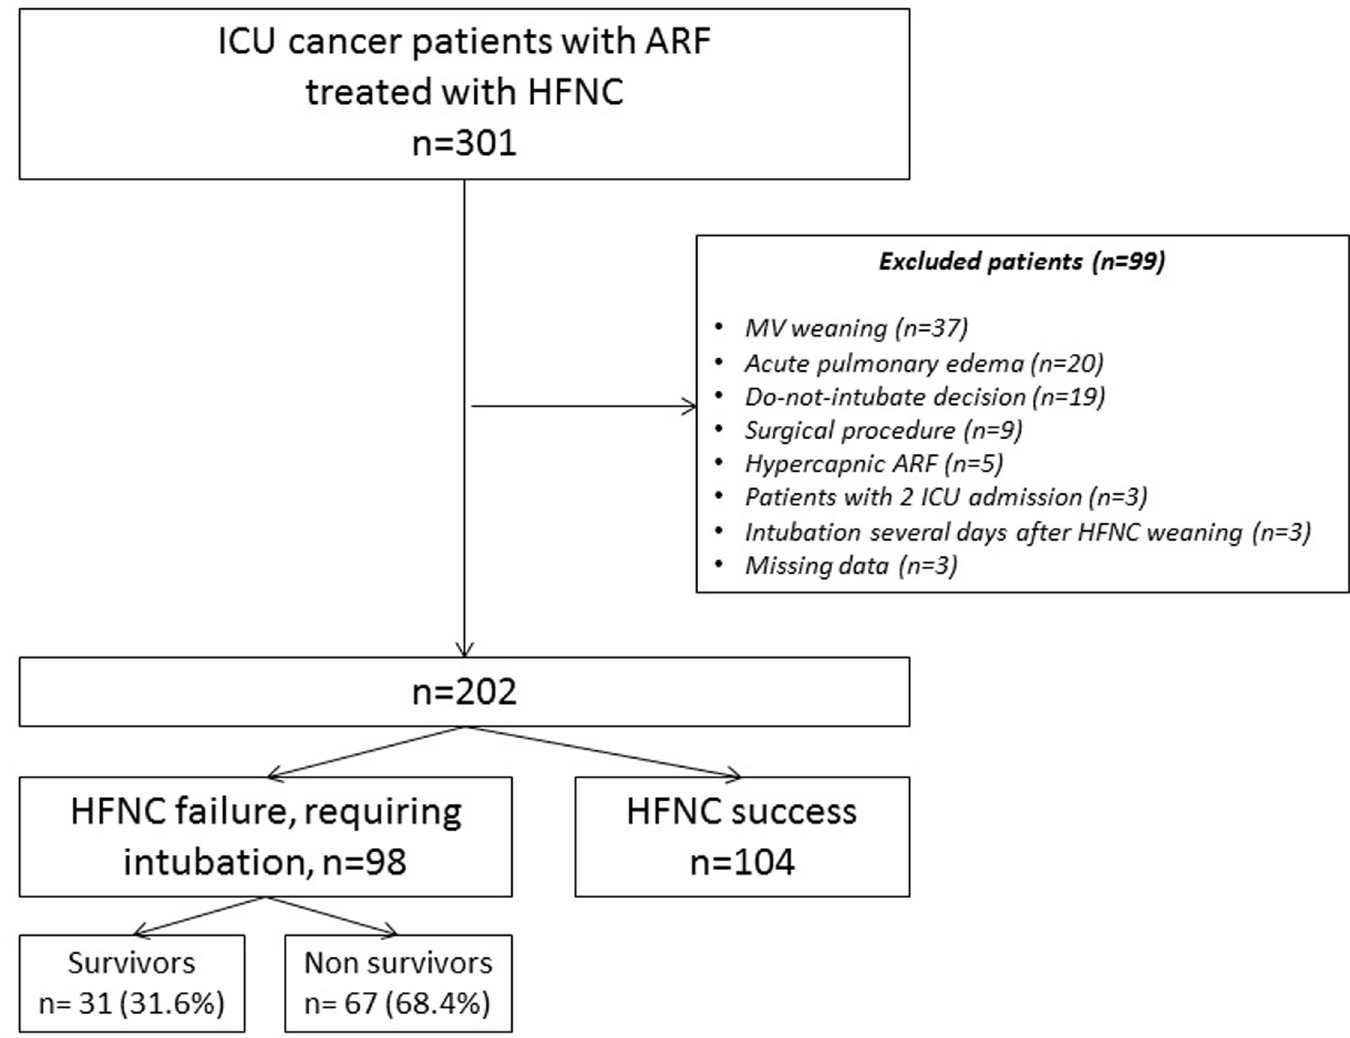
Fig 1. Flow chart of selected